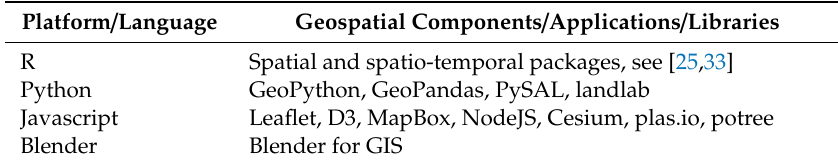
Table 3. General open source scientific computing platforms and modern data science languages with geospatial software development components /